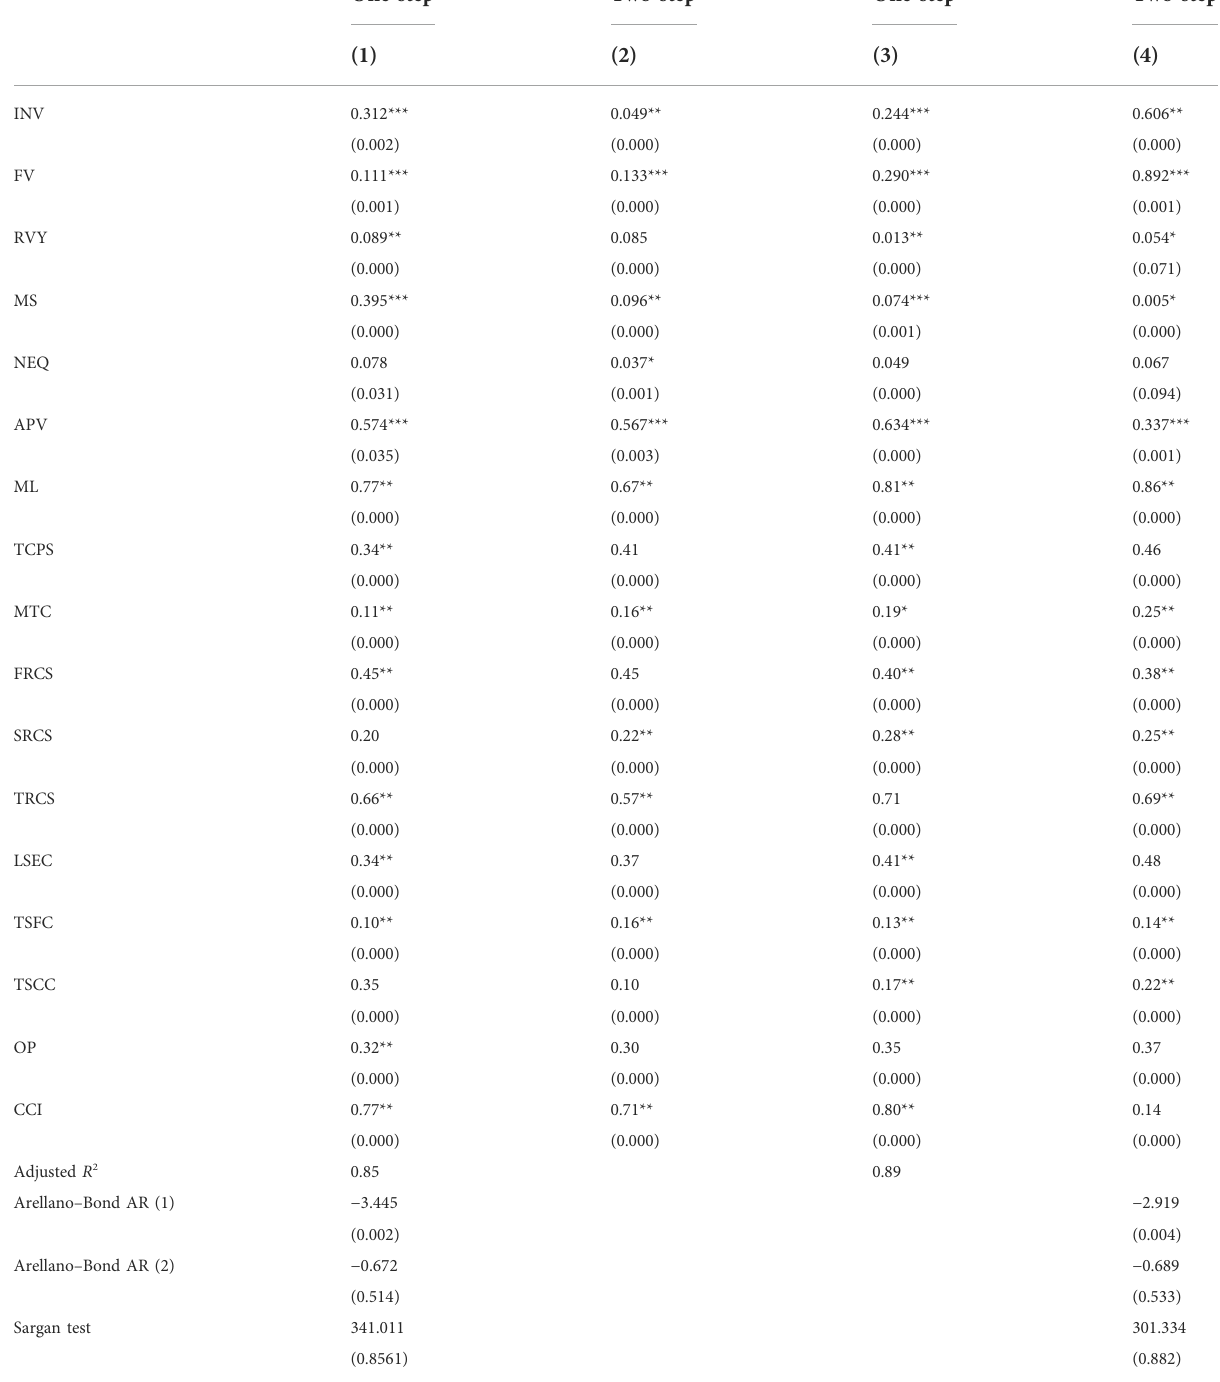
TABLE 2 One-step and two-step GMM